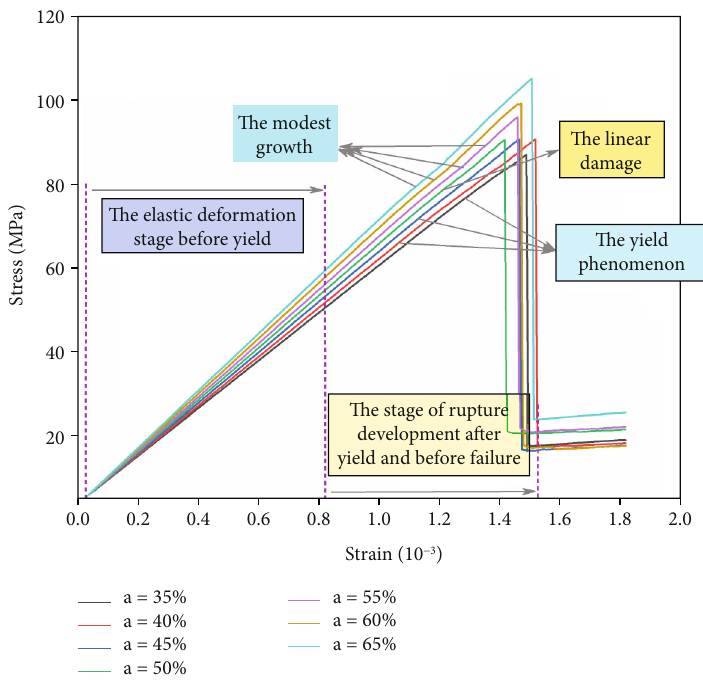
Figure 12: Stress-strain curves of shales with di ff erent quartz Table 3: Compressive strength and elastic modulus of shale samples.